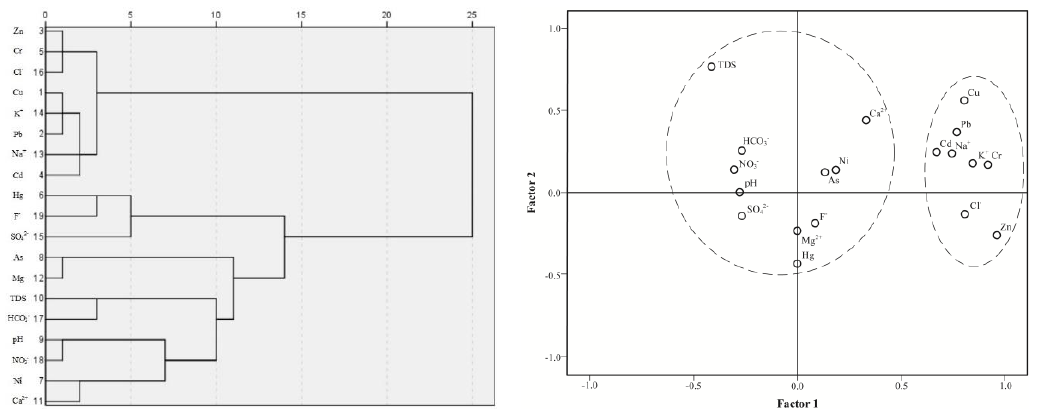
Figure 2. Cluster tree and scatter plots and of the 19 groundwater physicochemical indexes showing interrelationships among them.